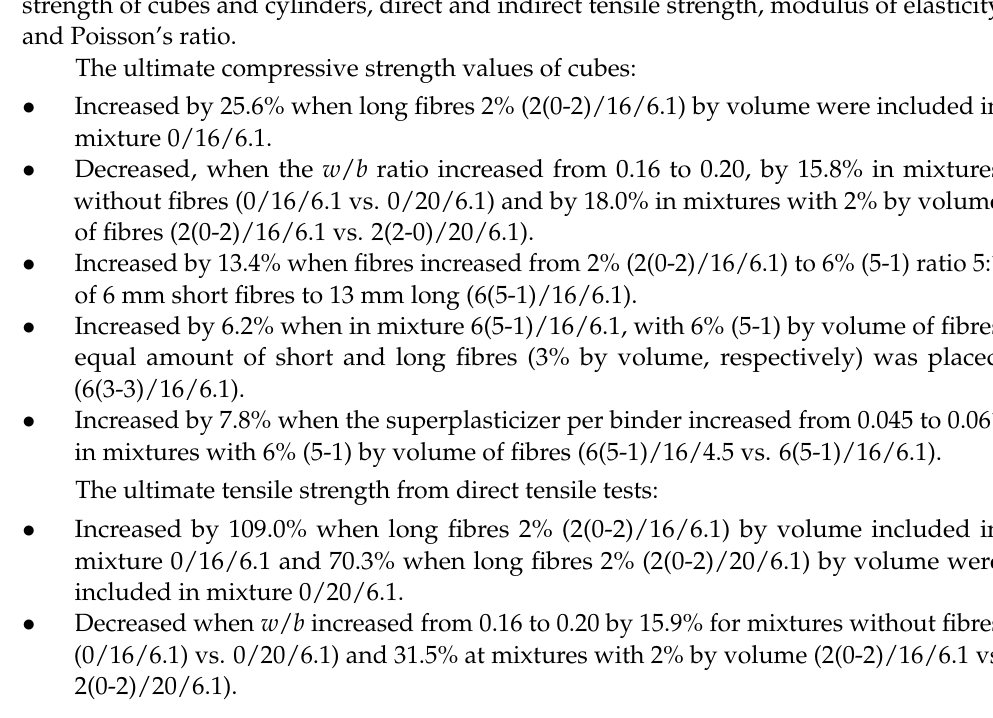
Figure 5. Set-up of flexural tension test.